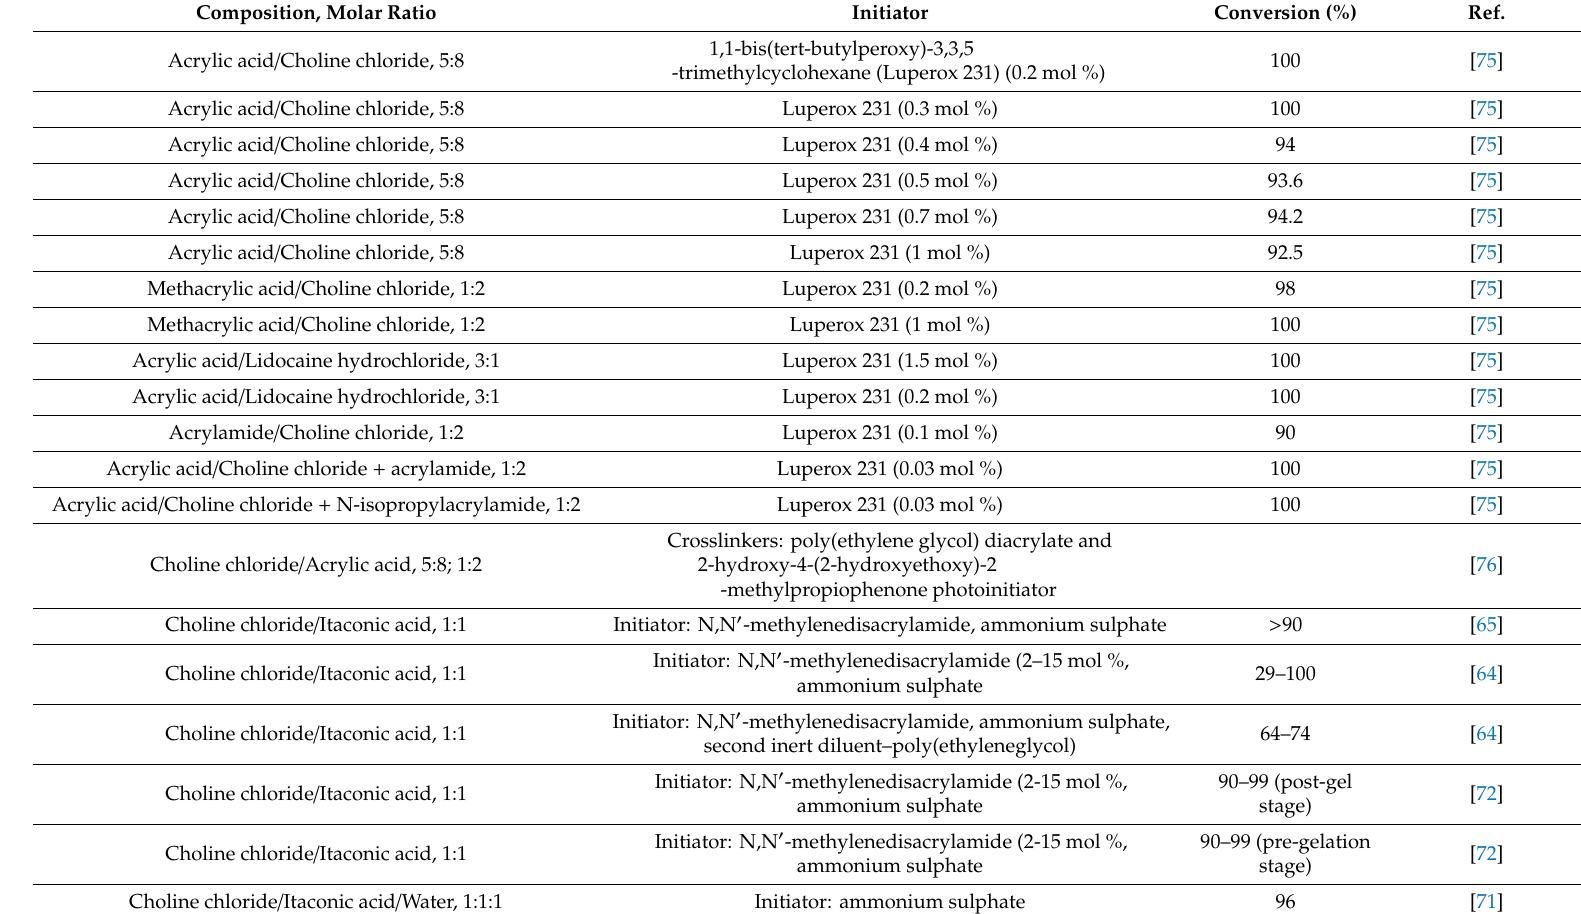
Table 7. Polymerizable